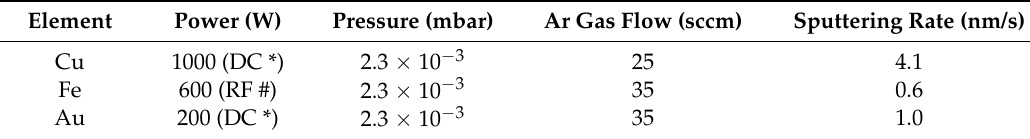
Table 1. Sputtering